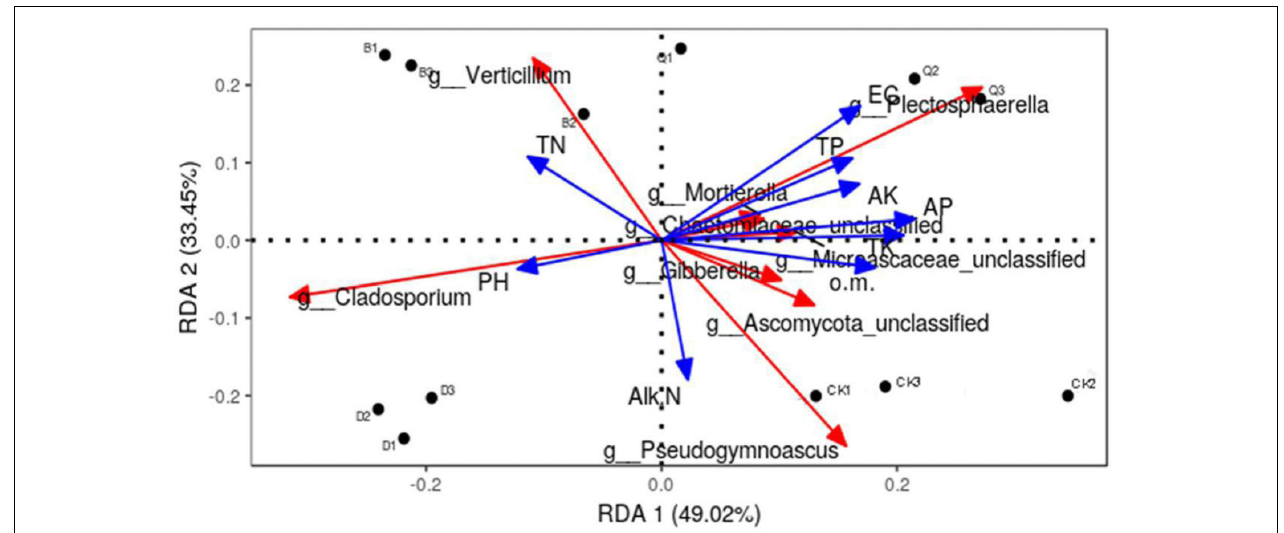
FIGURE 4 | Effect of environmental factors on the distribution of fungal communities in continuous tomato cropping substrates. Dots represent matrix samples; blue arrows represent the physical and chemical properties of the matrix; and red arrows represent the matrix microorganisms. The angle between the influencing factors (between the factors and the microorganisms) indicate a positive correlation between two factors (acute angle) and a negative correlation (obtuse angle), and the arrow length represents the strength of the effect for each factor. EC, matrix conductivity; pH, matrix pH; o.m., matrix organic matter; TN, total nitrogen; TP, total phosphorus; TK, total potassium; AP, available phosphorus; AK, available potassium; Alk N, alkali nitrogen. Treatment abbreviations are defined in Figure 1